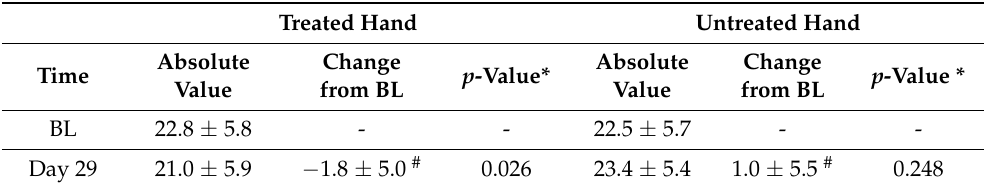
baseline (treated vs. untreated site), paired t